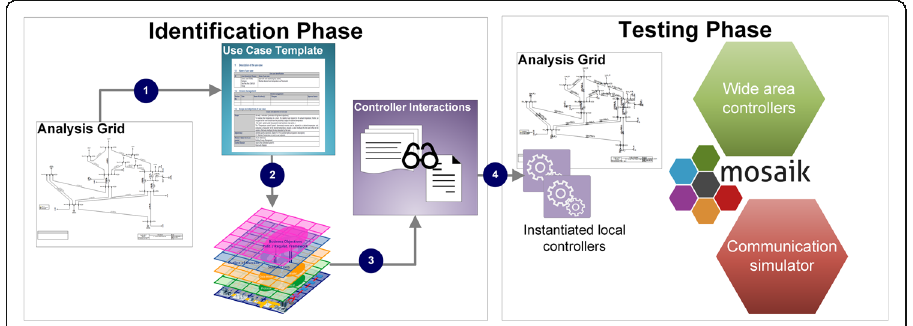
Fig. 2 Intended research artifact as a part of an integrated toolchain